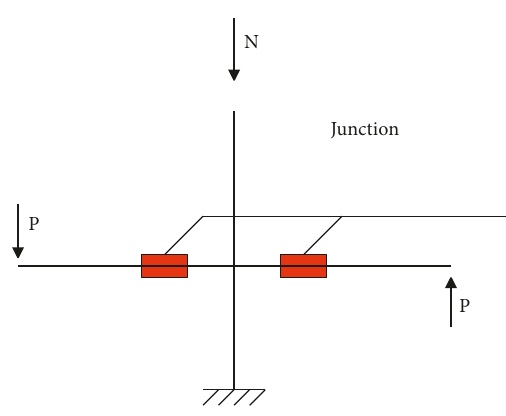
Figure 3: Steps of finite element analysis.